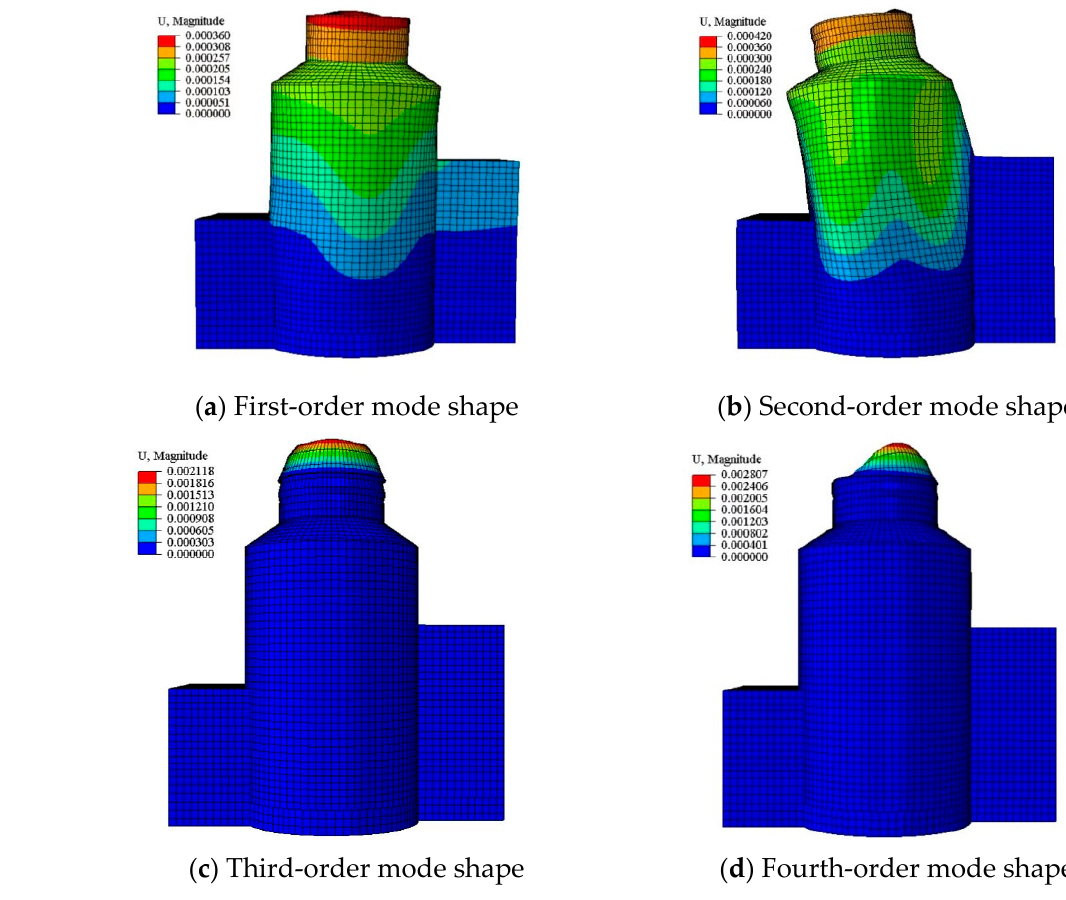
Figure 3. First four modes of the NPP structure.